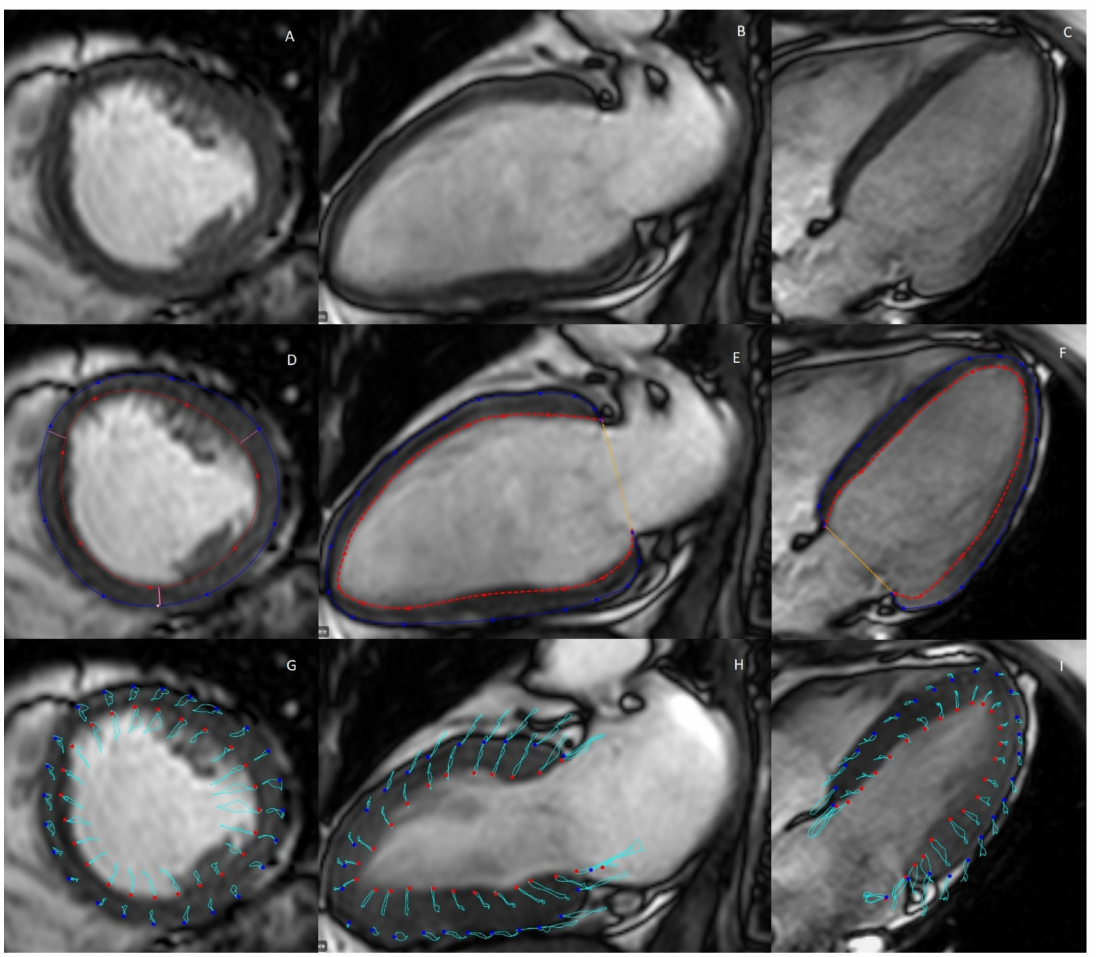
Figure 4. Typical example of calculation of myocardial strain with MRI feature tracking. ( A – C ): Anatomical cine MR images of the left ventricular short axis, long-axis 2-chamber, and long-axis 4-chamber view, respectively. ( D – F ) Delineation of the inner (red) and outer (blue) left ventricular wall in these image planes. ( G – I ) Feature tracking employed over the entire cardiac cycle, with pathing (the motion of myocardial features over time) made visible by the light-blue lines